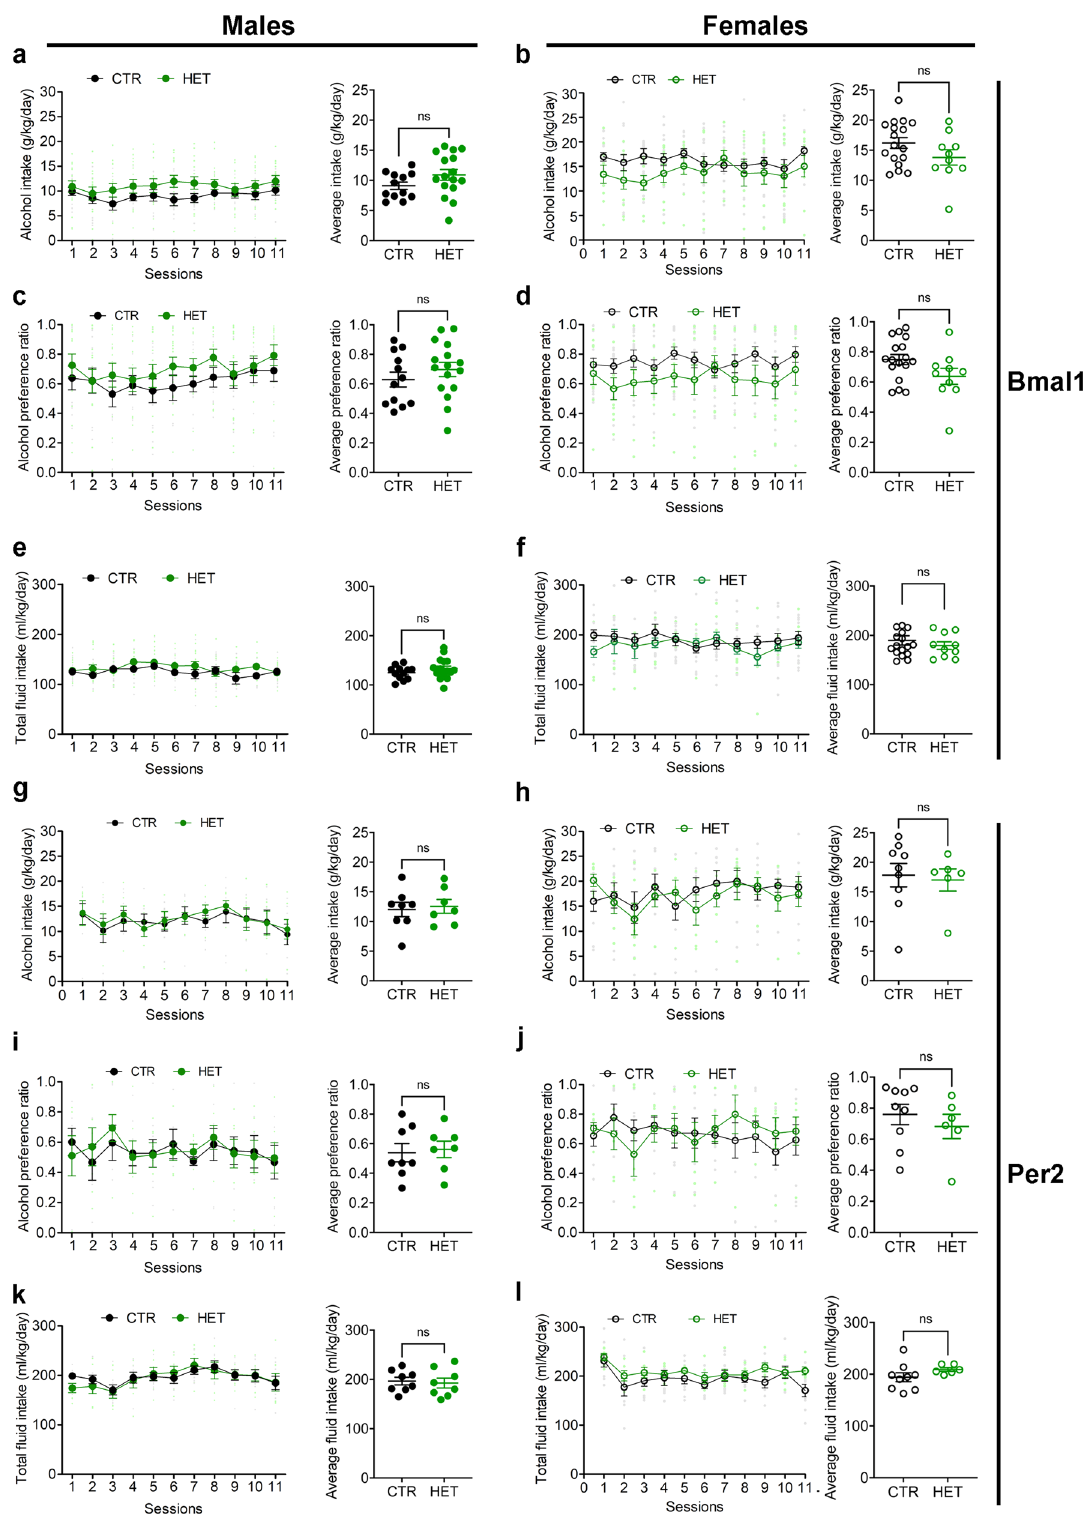
were due to Gpr88 haploinsuf fi ciency, or expression of Cre- EGFP in Gpr88 - bearing cells 46 . Sex differences in alcohol behavior are well recognized in rodents, with females generally drinking more alcohol than males 33 – 35 . Consistent with this, average daily alcohol intake and preference in female control mice was signi fi cantly greater than in males (Supplementary Fig. 2a, d). In contrast, mean alcohol